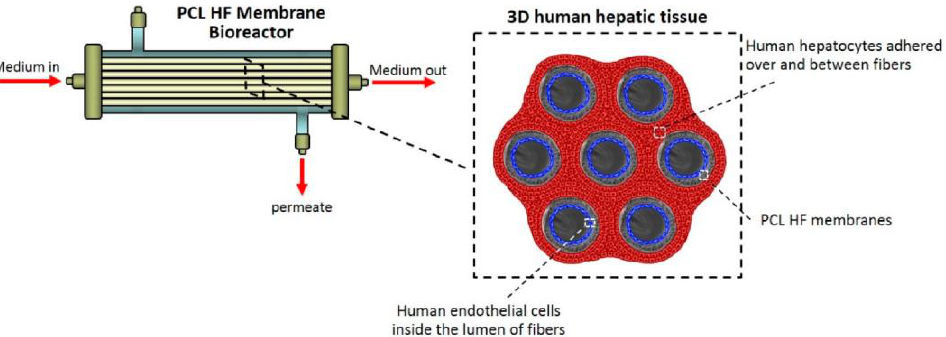
Figure 5. Poly(ε -caprolactone) (PCL) hollow fiber (HF) membrane bioreactor and scheme of the 3D human hepatic tissue realized by culturing human hepatocytes over and between PCL HF membranes parallel assembled at a distance of 250 µm, and endothelial cells compartmentalized in the lumen of the fibers. The cells were in communication through the porous wall of the membranes (reproduced with permission after [204] ).